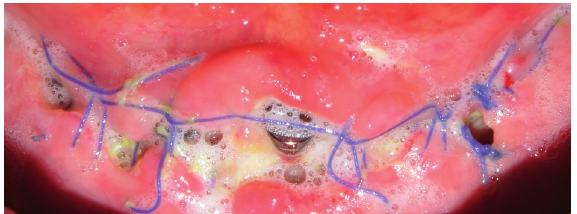
Figure 9: Surgical cleaning of the implant area.